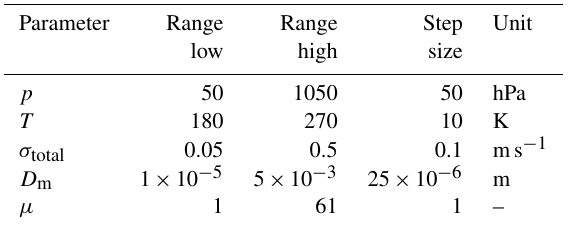
Table 1. Ranges and step sizes for the computation of the lookup table.